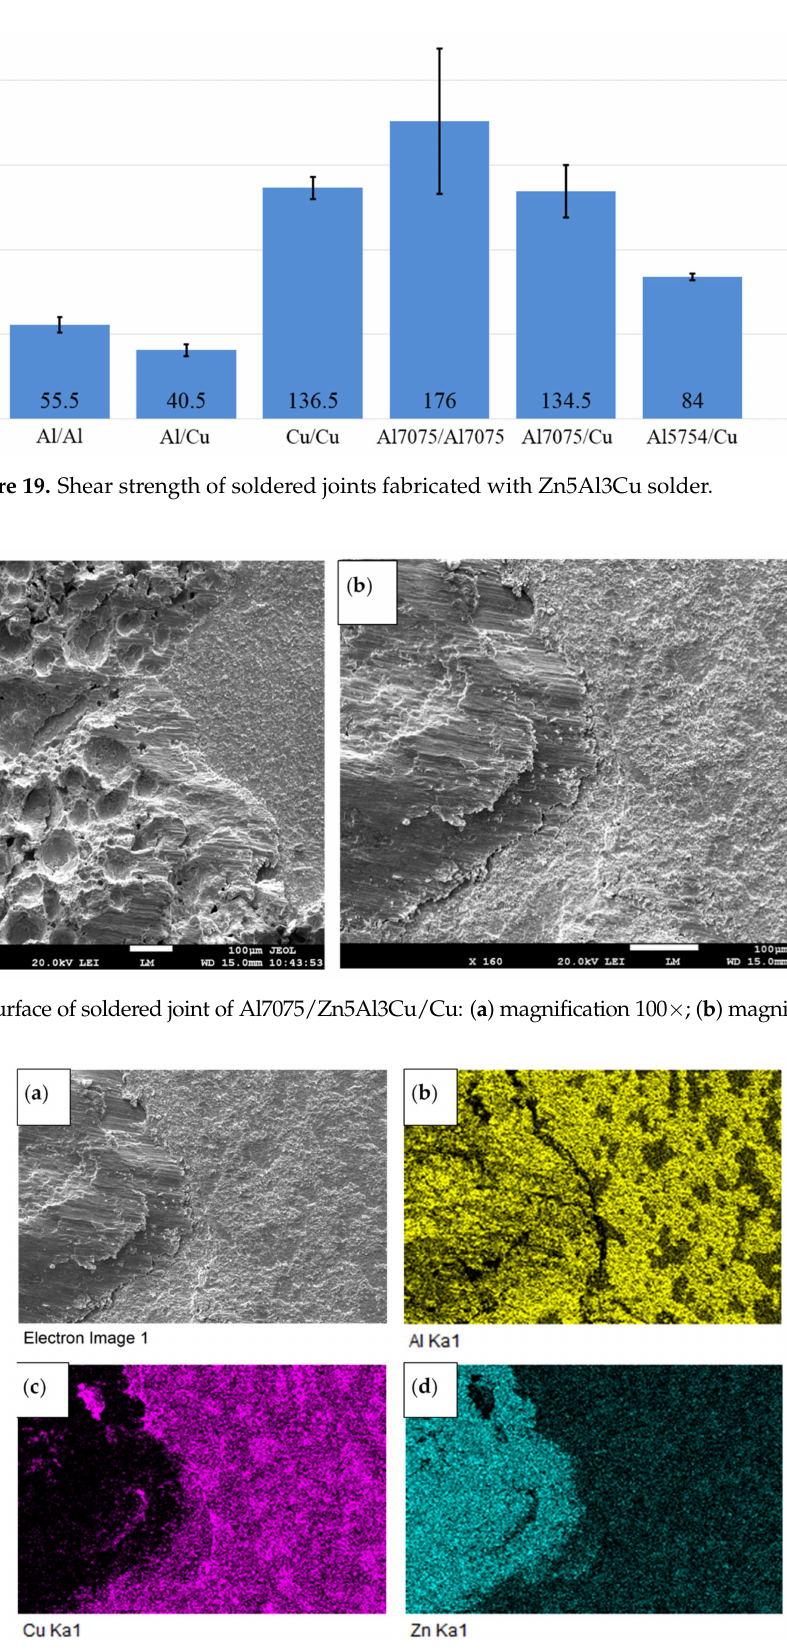
Figure 21. The fractured surface of soldered joint of Al7075/Zn5Al3Cu/Cu and planar distribution of individual elements: ( a ) structure of fracture; ( b ) Al; ( c ) Cu; ( d )